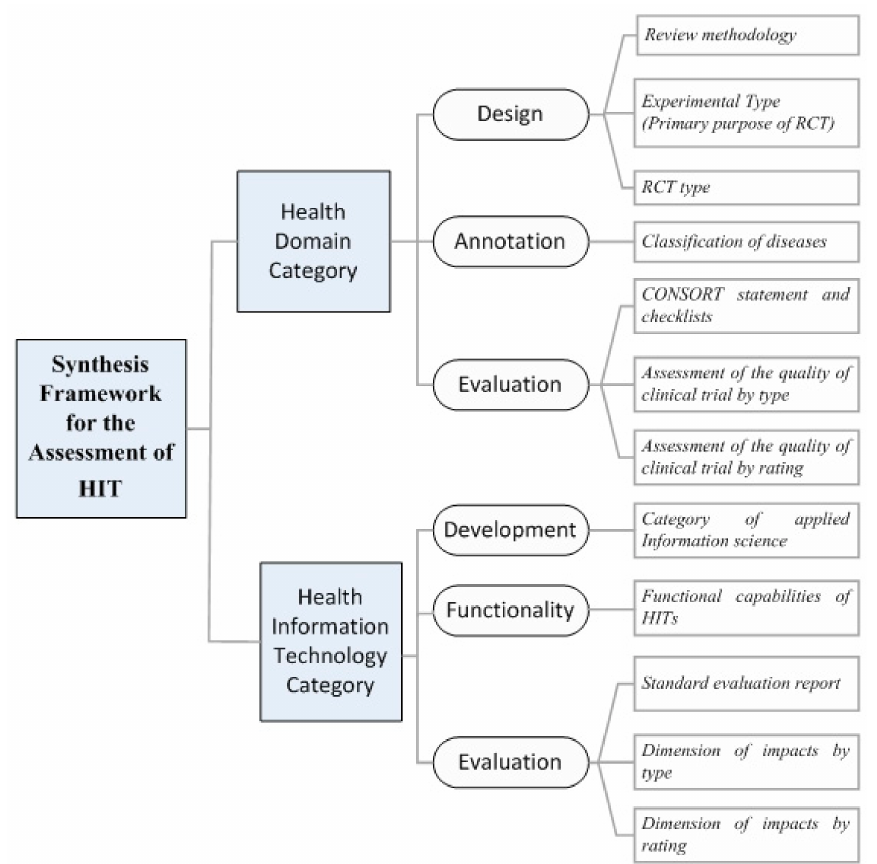
Figure 2. Synthesis framework for HTA